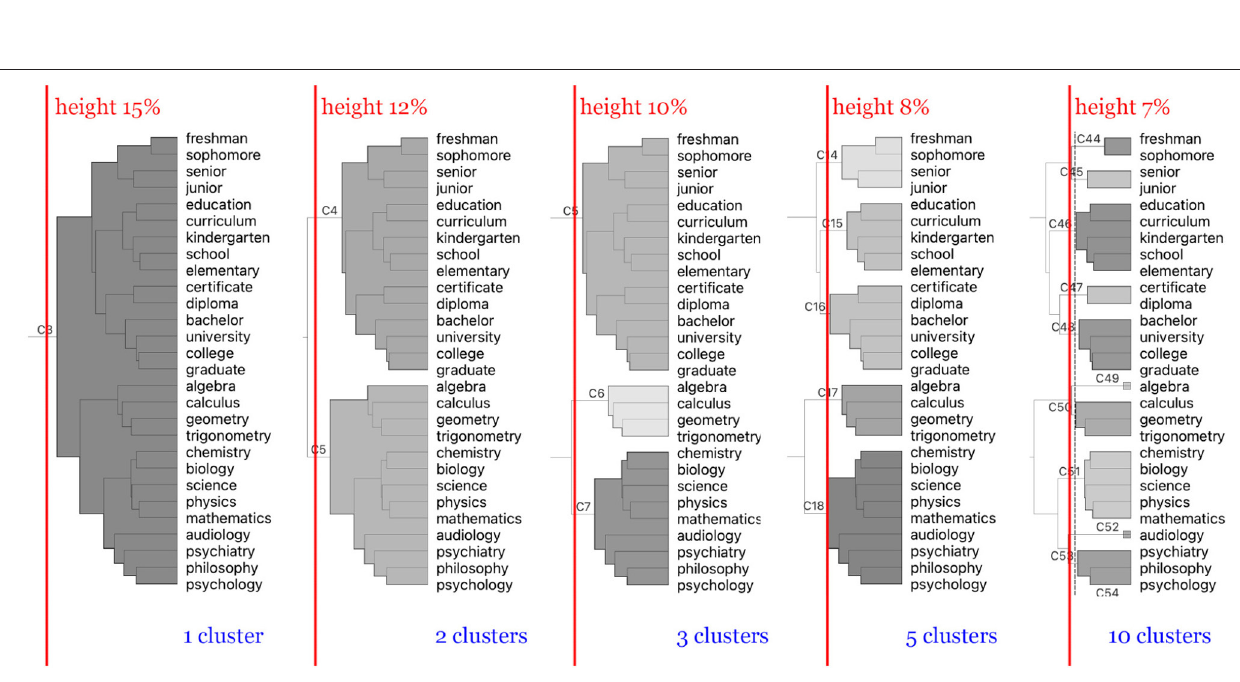
FIGURE 5 | Different groupings by pruning height of signs in the ASL dataset with respect to different pruning heights indicated with the red lines. As the pruning height decreases from left to right, the number of clusters increases. Lower heights prune the hierarchical tree at junctions closer to the terminal leaf nodes; hence, a larger number of resulting clusters with fewer